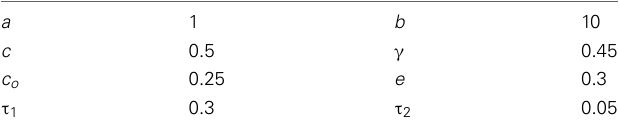
Table A3 | Parameter table of the obstacle interaction